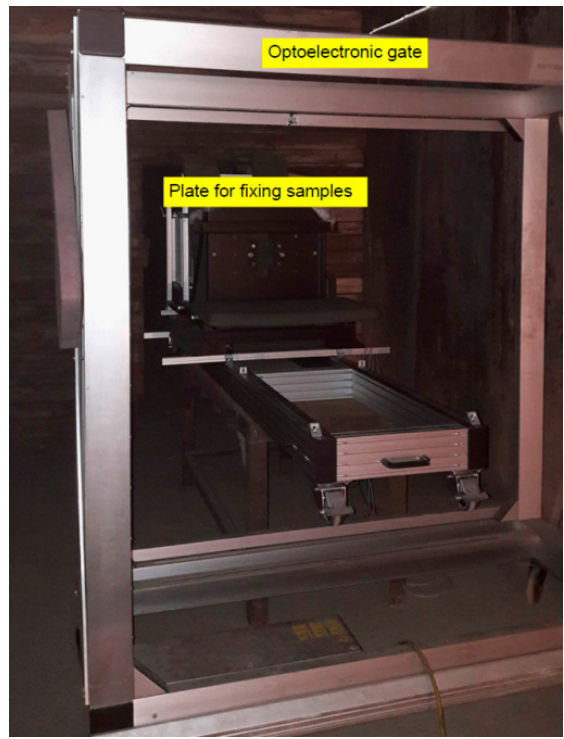
Figure 2. View of the optoelectronic gate to measure the velocity of projectiles before penetrating the sample.